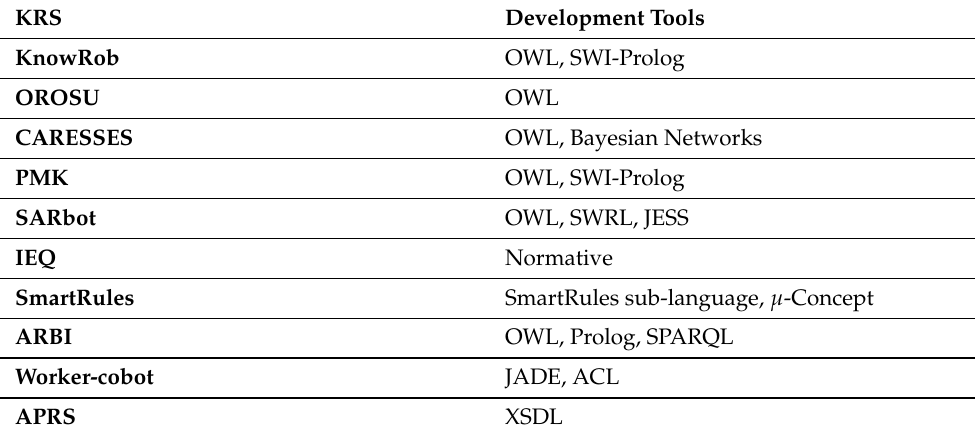
Table 5. KRSs: development